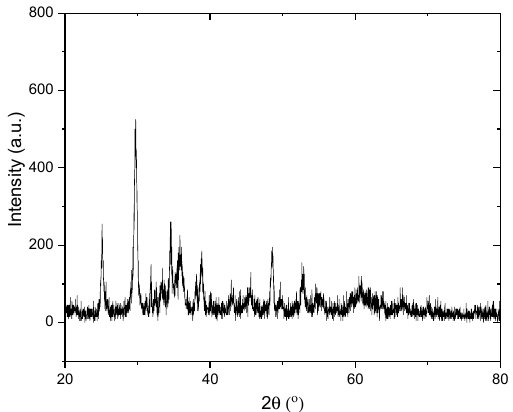
Figure 2. XRD patterns of the TiO 2 nanotubes (TiO 2 -NTs).